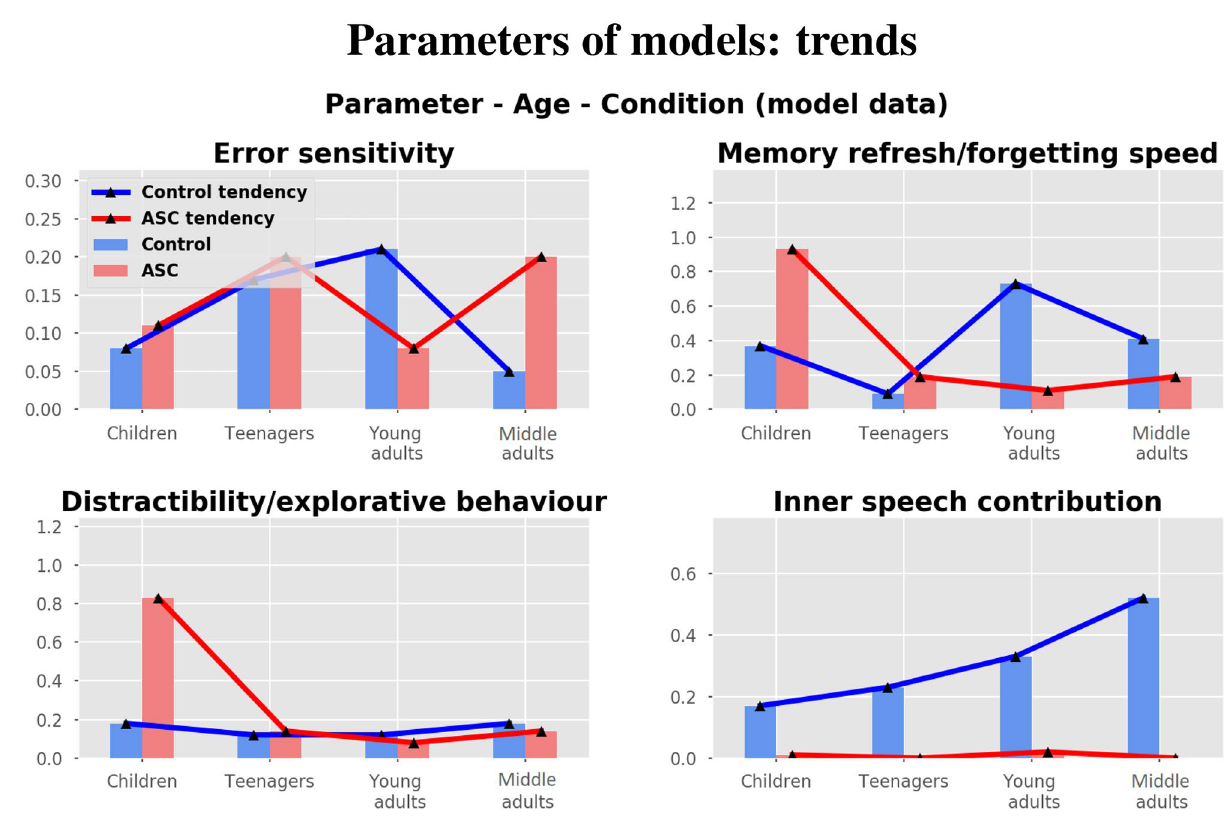
Figure 2. Graphic visualisation of the parameters of the models that best fit the datasets of the human groups (Children, Teenagers, Young adults, Middle